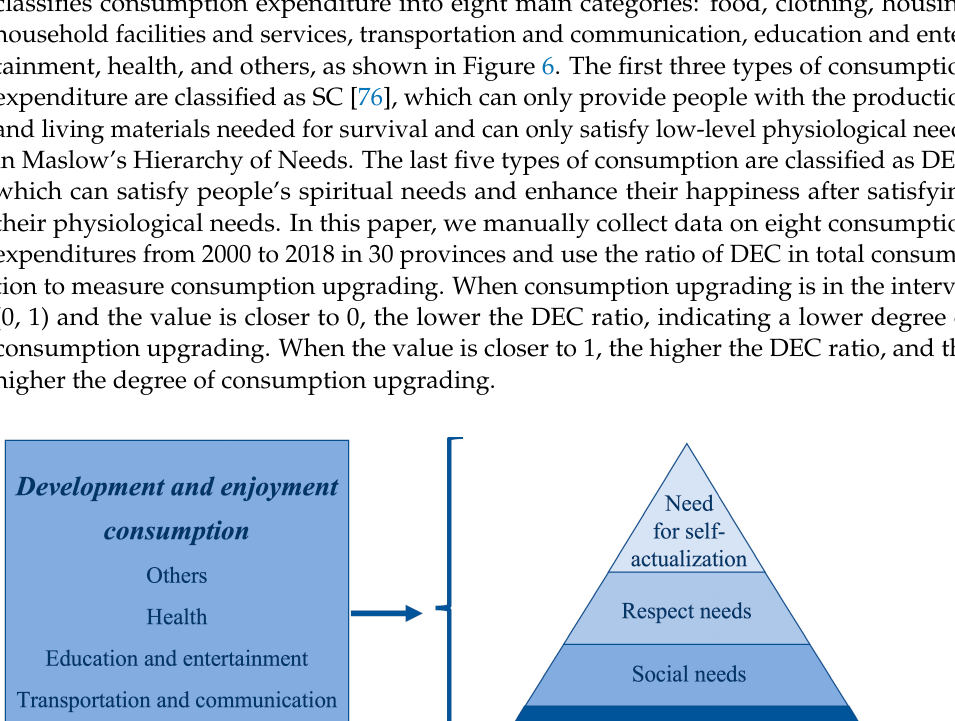
Figure 5. Distribution of Internet development in 2018.